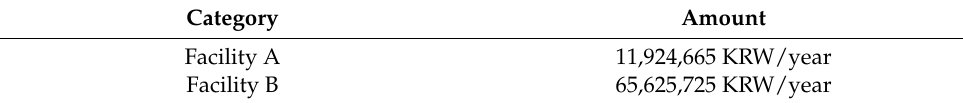
Table 3. Environmental improvement